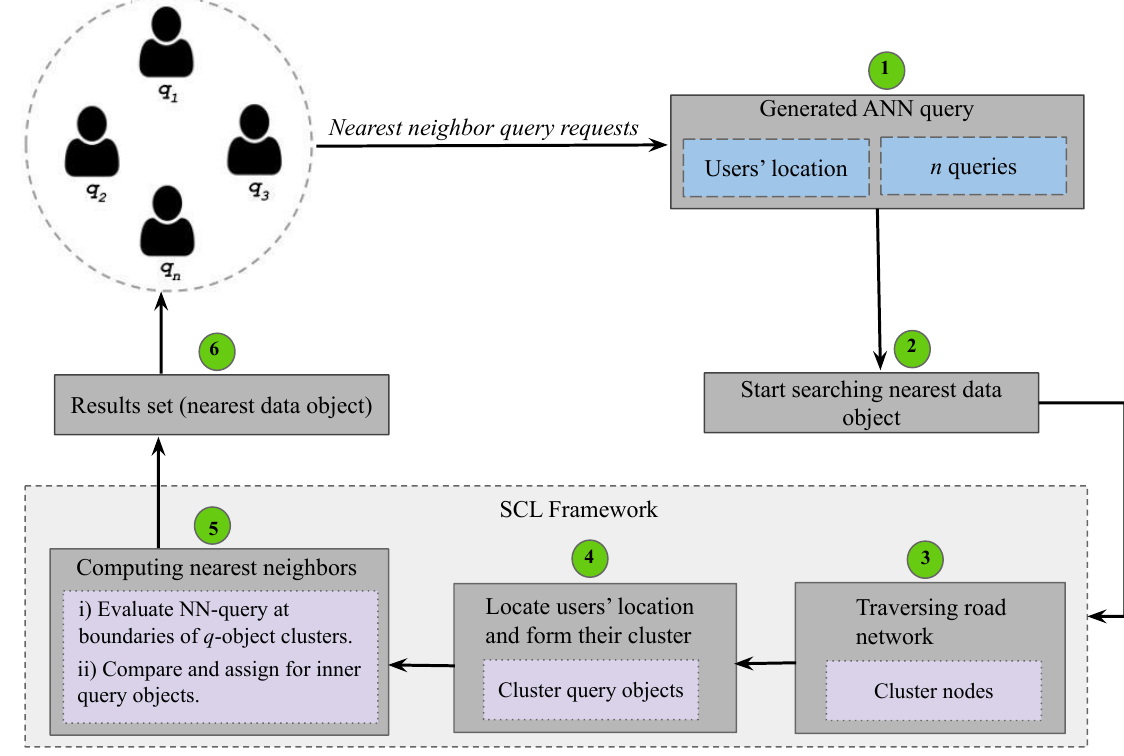
Figure 2. Workflow diagram of the proposed query processing methodology.